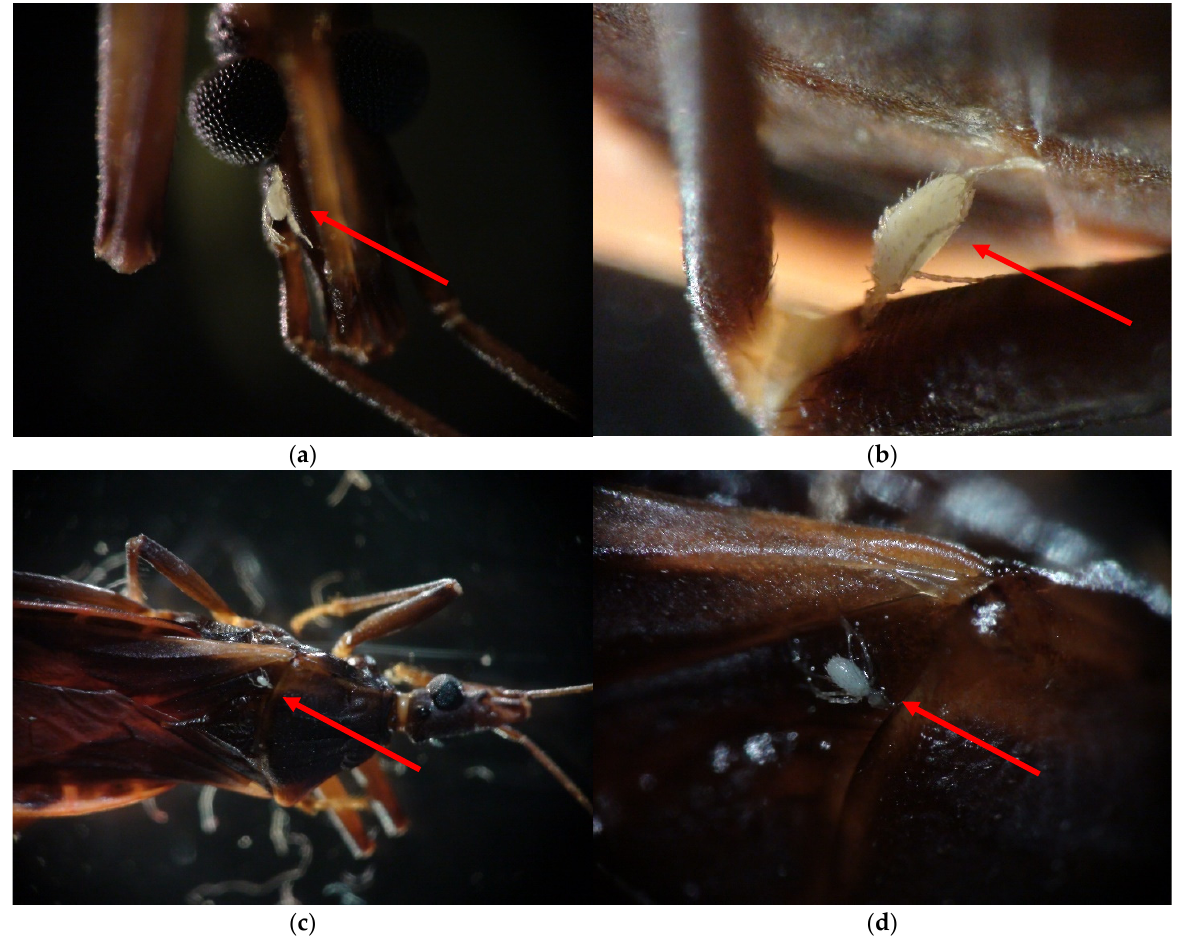
Figure 2. Mite locations on triatomines. Red arrows highlight the presence of mites on T. rubida specimens: locations included the ( a ) head (40× magnification); ( b ) legs (112.5× magnification); ( c ) and ( d ) thorax (15× and 45× magnification, respectively).